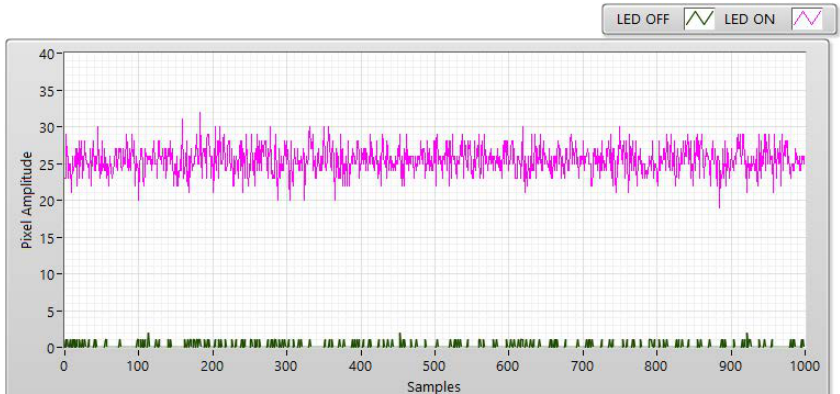
Figure 6. SNR measurement with a Point Grey rolling shutter camera at a communication distance of 5 m with 100 µs.